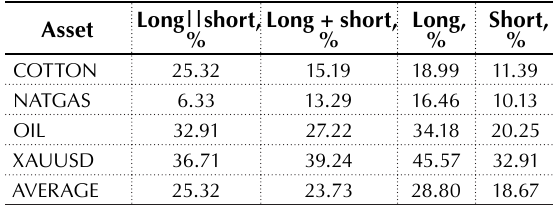
Table 2. Sums of profits during the 79